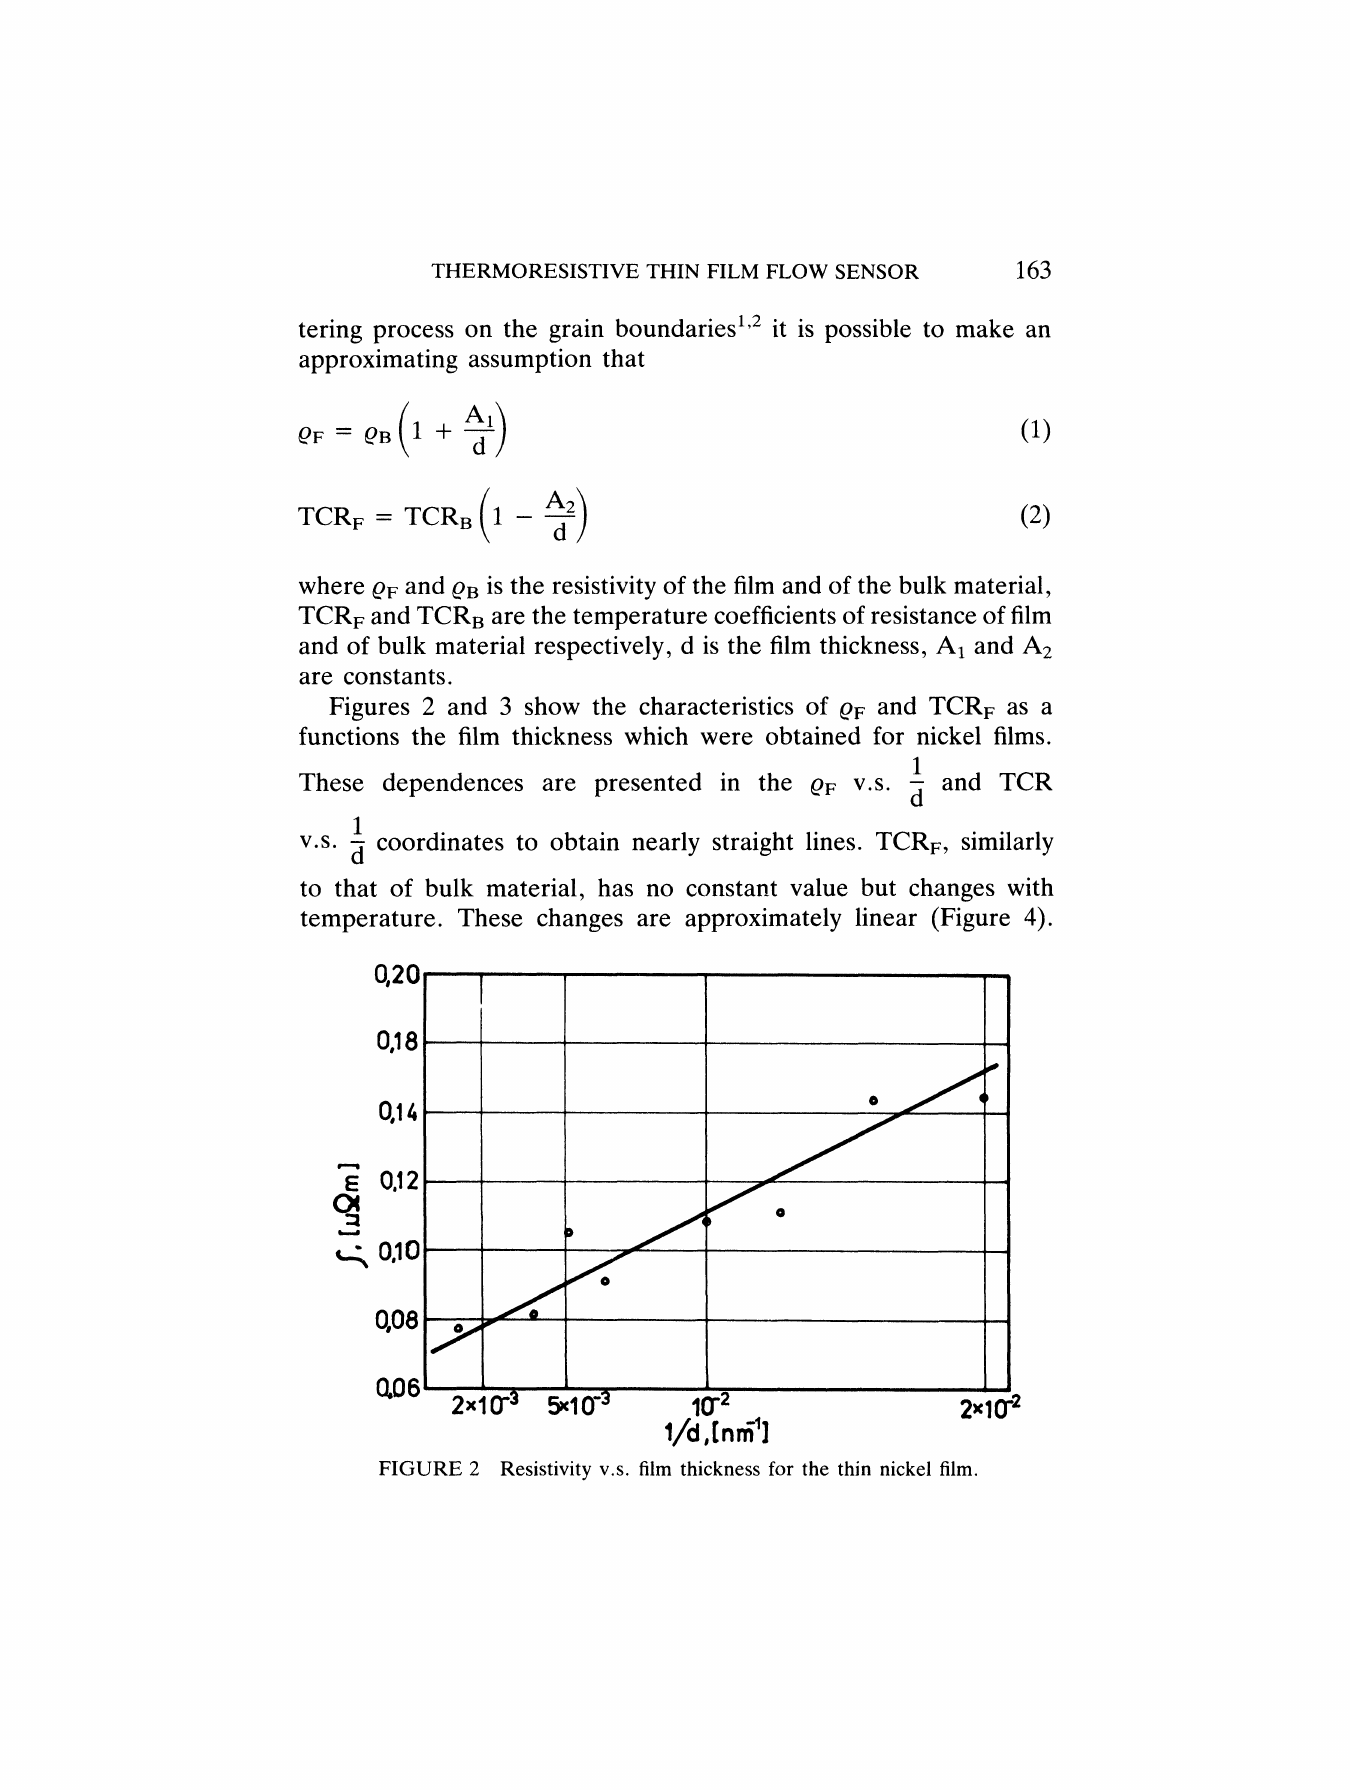
FIGURE 2 Resistivity v.s. film thickness for the thin nickel